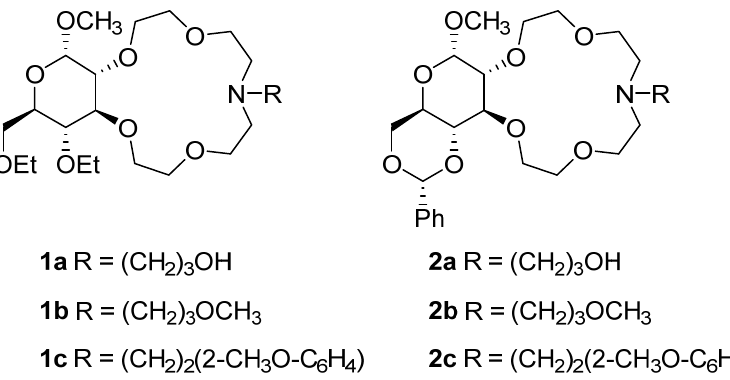
Figure 1. Crown ethers derived from 4,6-di- O -ethyl-glucoside ( 1a – c ) and their 4,6- O -benzylidene analogues ( 2a – c